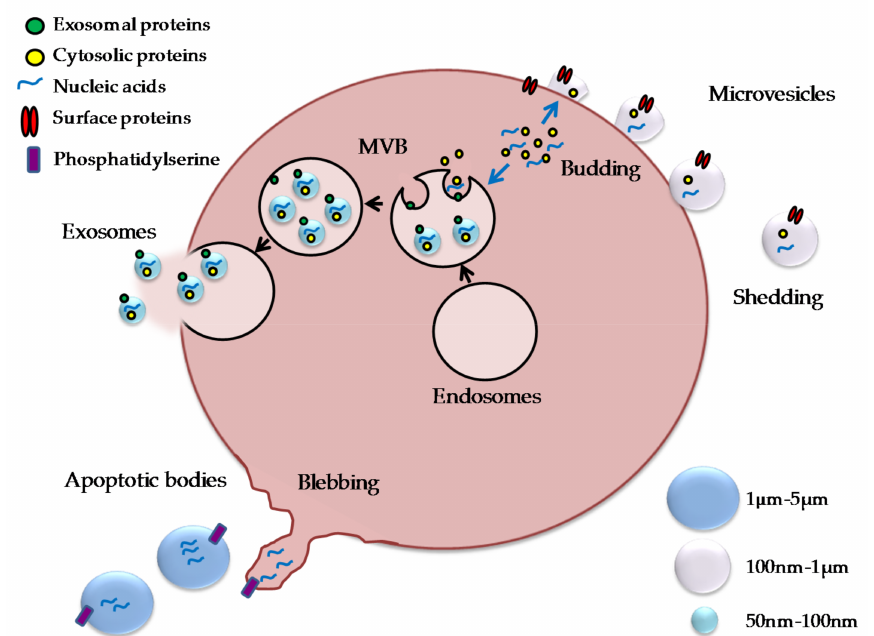
Figure 2. Extracellular vesicles. Exosomes, microvesicles, and apoptotic bodies differ in dimensions and biogenesis. They carry several molecular components, including cytosolic and membrane proteins, receptors, and nucleic acids. Exosomes are small vesicles (50–100 nm) that are derived from multivesicular bodies (MVB), and are released by fusion of MVB with the cell membrane; microvesicles are larger vesicles (100 nm–1 µ m) and are derived from budding of the plasma membrane; apoptotic vesicles have a size ranging from 1 to 5 µ m, and are released by the blebbing process during apoptosis. Microvesicles are membrane vesicles with a diameter ranging from 100 nm to 1 µ m. They